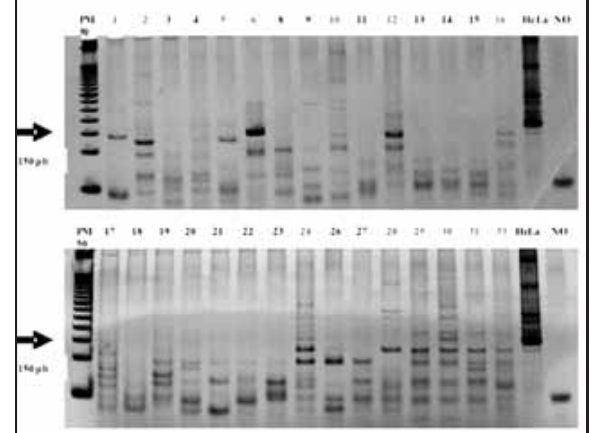
Figura 2 – Eletroforese em gel de poliacrilamida a 8% mostrando resultado da amplifi- cação do HPV (150 pb) por PCR nas 30 amostras de carcinoma epidermoide de lábio. PM 50 = peso molecular de 50 pb (50 pb DNA Ladder, Invitrogen); linhagem de células HeLa = controle positivo para DNA do HPV; NO = controle negativo, sem